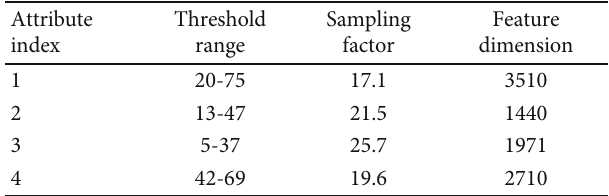
Table 1: Description of image binarization processing